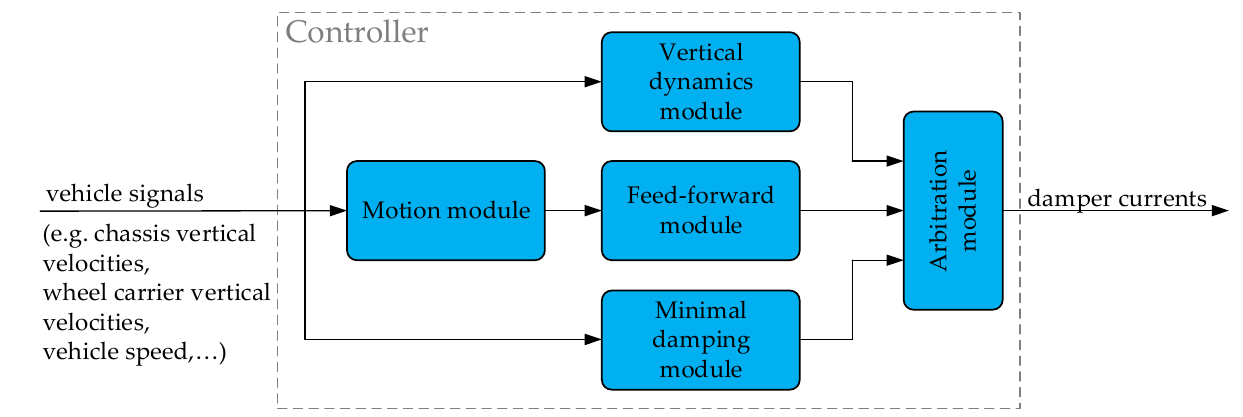
Figure 5. The vertical dynamics controller scheme.